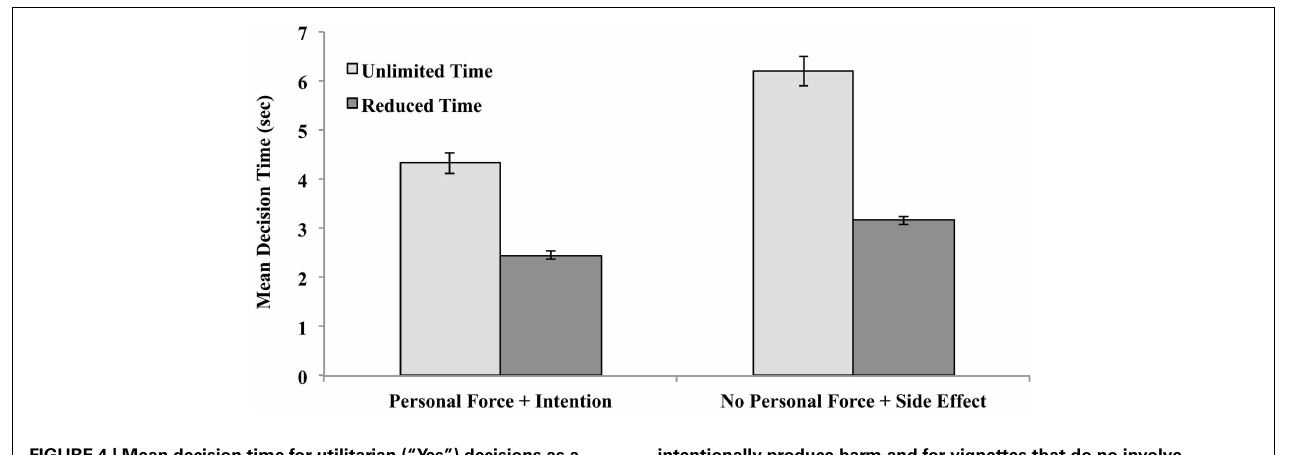
intentionally produce harm and for vignettes that do no involve the use of personal force but yield harm as an unintended side effect in Experiment